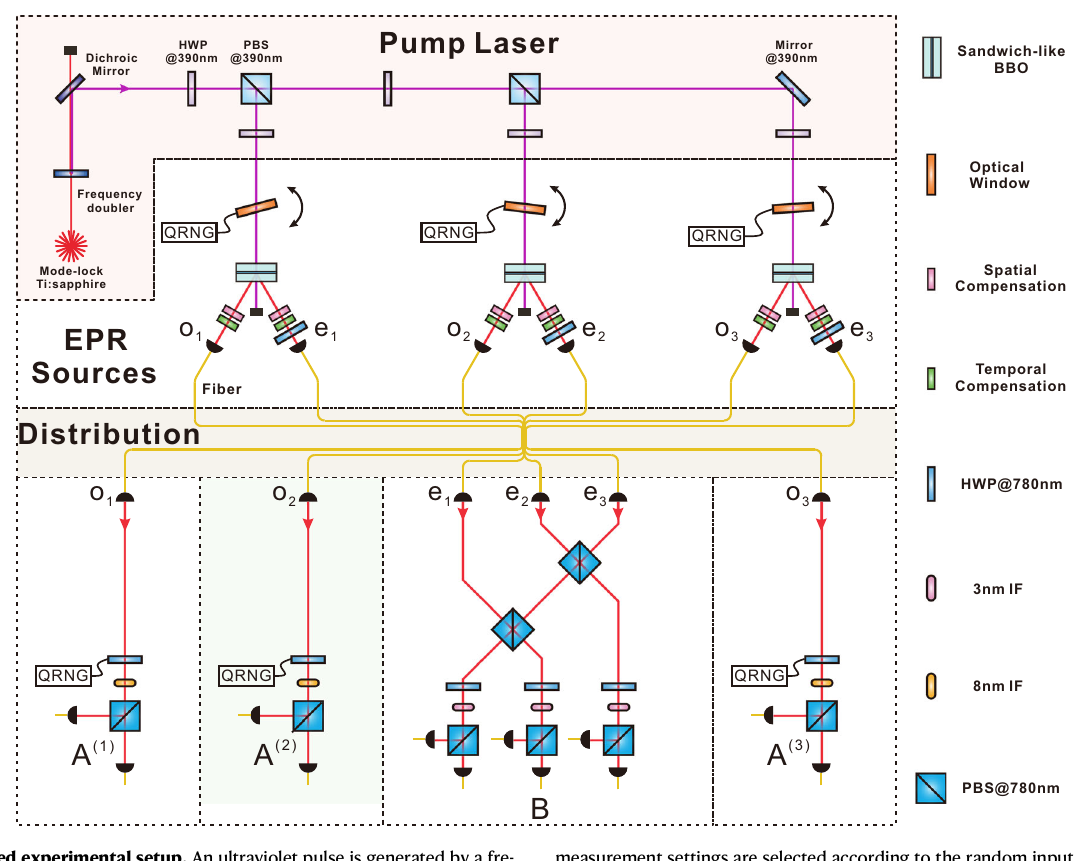
measurement settings are selected according to the random input. Extraordinary photons are projected into the GHZ state at the central node. PBS polarisation beam splitter, HWP half-wave plate, IF interference fi lter, QRNG quantum random number generator, BBO, beta barium